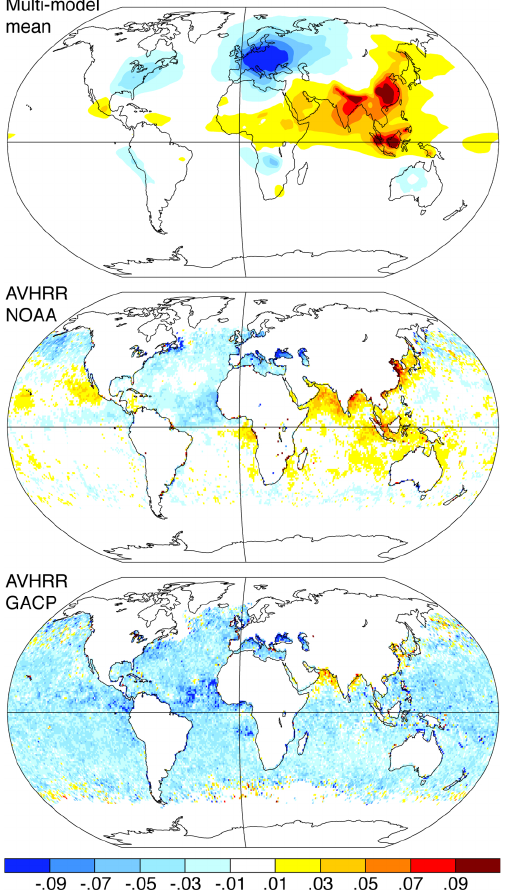
∼ 1980 to ∼ 2000. The multi-model mean (top) compares the 2000 and 1980 timeslice simulations. Observations are based on AVHRR data and show the difference between the 1997–2003 and 1981– 1987 (excluding March 1982–Decenber 1984) averages based on the NOAA product (center) and the GACP product